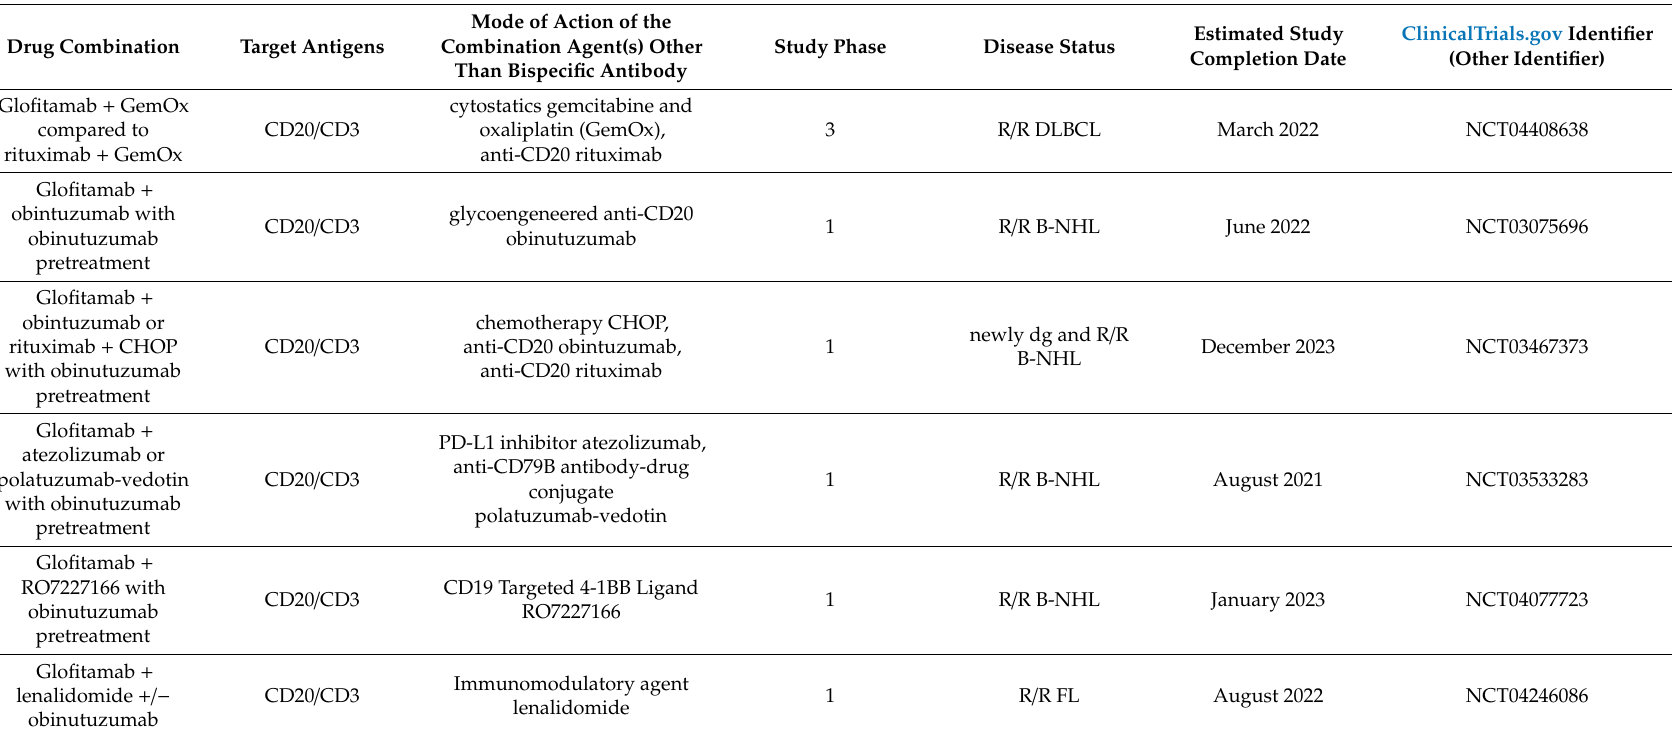
Table 3. Selected clinical trials that incorporate glofitamab in experimental therapy of